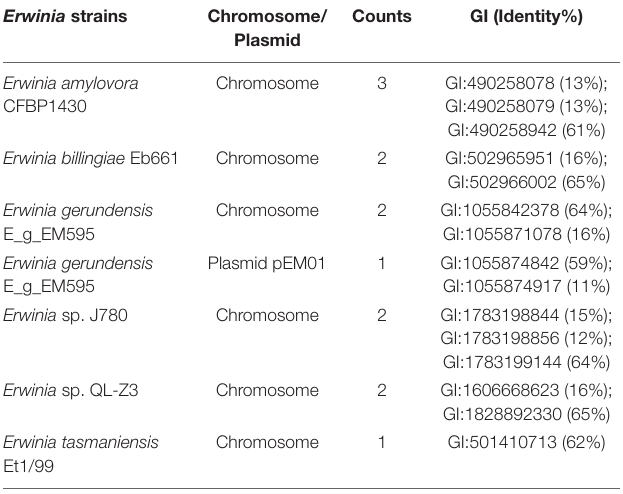
TABLE 4 | Identity of plasmid-borne LacZ in Erwinia sp. E602 with its paralogs in other Erwinia species. Erwinia strains